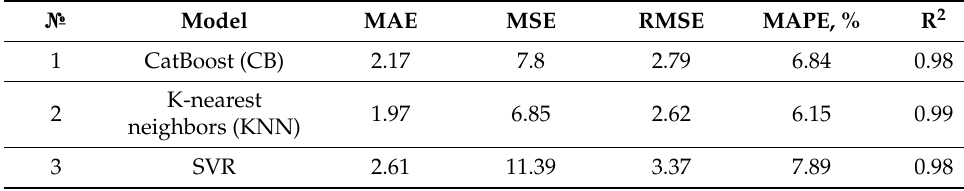
Table 12. Metrics of the developed